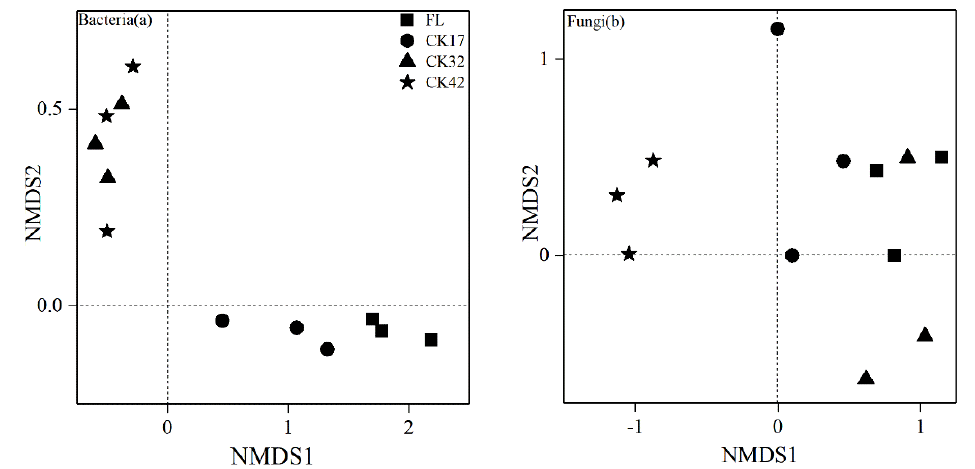
Figure 3. Non-metric multi-dimensional scaling analysis (NMDS) of the beta diversity of soil bacterial ( a ) and fungal ( b ) communities based on Bray–Curtis distances among different stages of vegetation restoration.